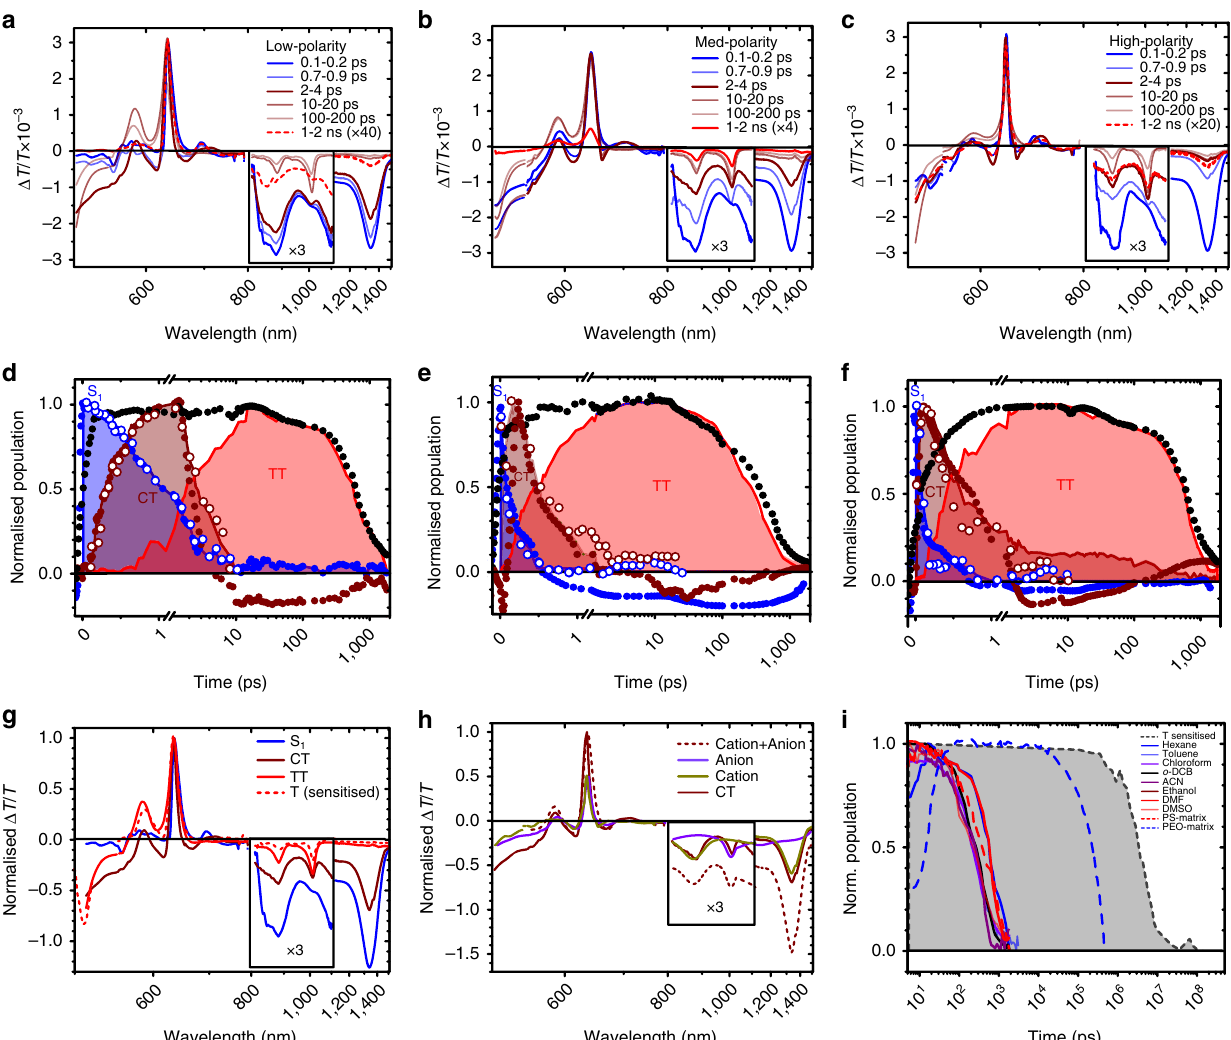
Figure 5 | SF in DP-TIPS. TA spectra of DP-TIPS in ( a ) low-polarity hexane, ( b ) medium-polarity o -DCB and ( c ) high-polarity DMF at indicated time delays. The dashed line showing the spectrum measured on long time-scales and the entire NIR spectral region have been magnified for clarity. Corresponding TA decay kinetics (filled symbols) in ( d ) hexane, ( e ) o -DCB and ( f ) DMF reveal the presence of multiple species. Kinetics are averaged over ranges 615–620nm (CT PIA, brown), 635–645nm (GSB, black) and 680–690nm (S 1 SE, blue). S 1 and CT kinetics are closely matched by results from the separate transient grating PL experiment (open symbols, S 1 : blue and CT: brown). Population kinetics extracted from spectral decomposition (filled regions) illustrate a sequential S 1 - CT - TT progression, with residual S stab population in hexane and residual CT population in DMF. ( g ) Three distinct spectral species extracted from TA data (solid). The peak positions of the triplet pair TT match those determined from a separate sensitisation experiment (dashed), though the ratio of PIA to GSB is reduced in sensitisation due to the presence of only one triplet. ( h ) The spectral shape of the extracted CT PIA can be well reproduced as a combination (dashed) of anion and cation spectra from chemical oxidation and reduction. Note it is not physically possible to reproduce the SE band at 700nm without directly generating CTstates. ( i ) Comparison of normalized TTpopulation kinetics for the full range of solvents and polymer matrices studied here to the intrinsic single-triplet lifetime from sensitisation (filled). The decay of TT is orders of magnitude faster due to rapid intramolecular TTA, except in the unique PEO matrix. Full TA, transient grating PL and sensitisation results are presented in Supplementary Figs 8, 16–19, 21 and